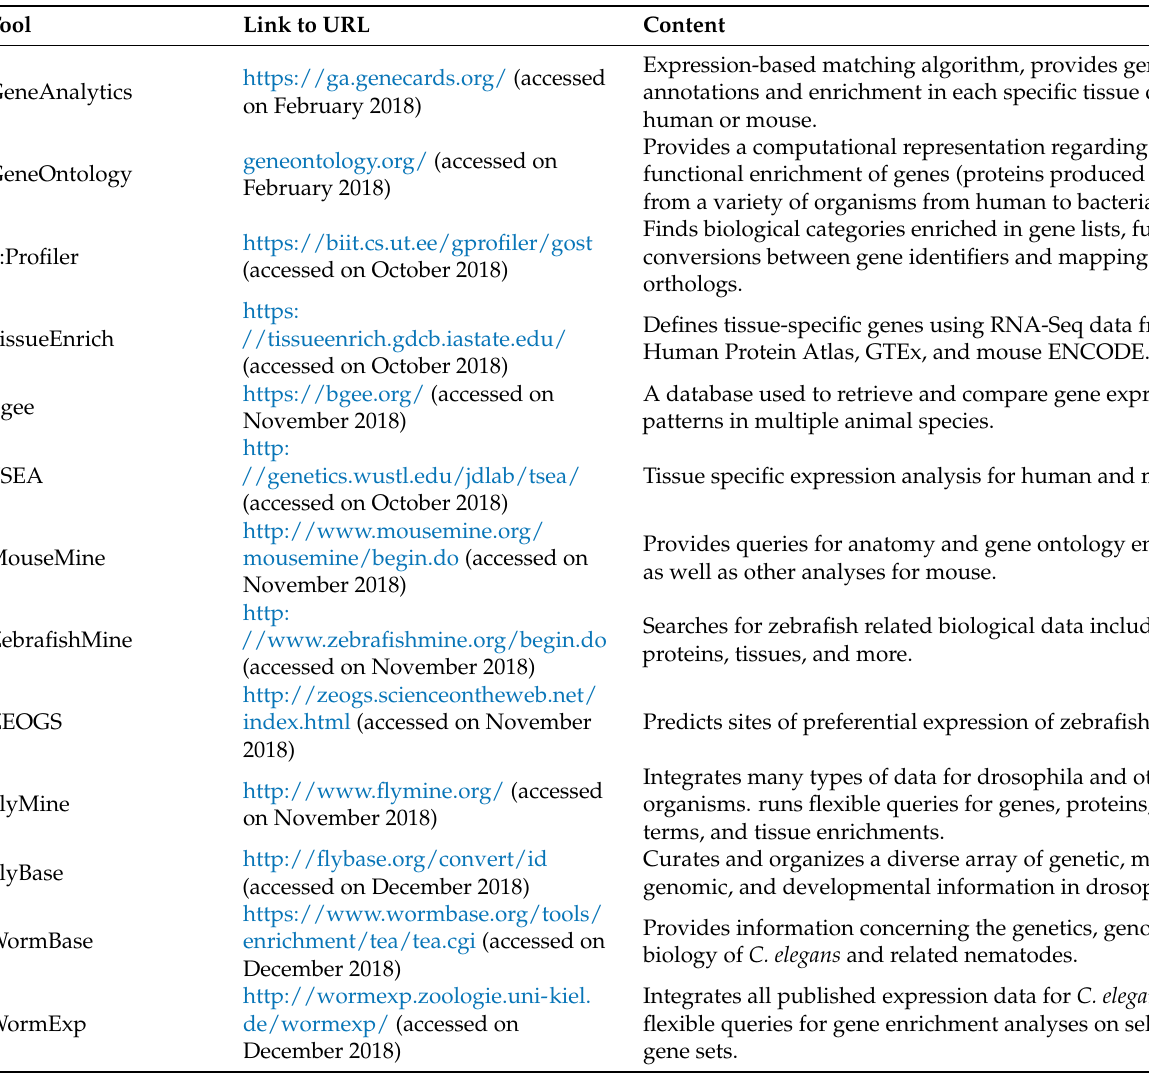
Table 1. Tissue enrichment and functional annotation tools utilized in this